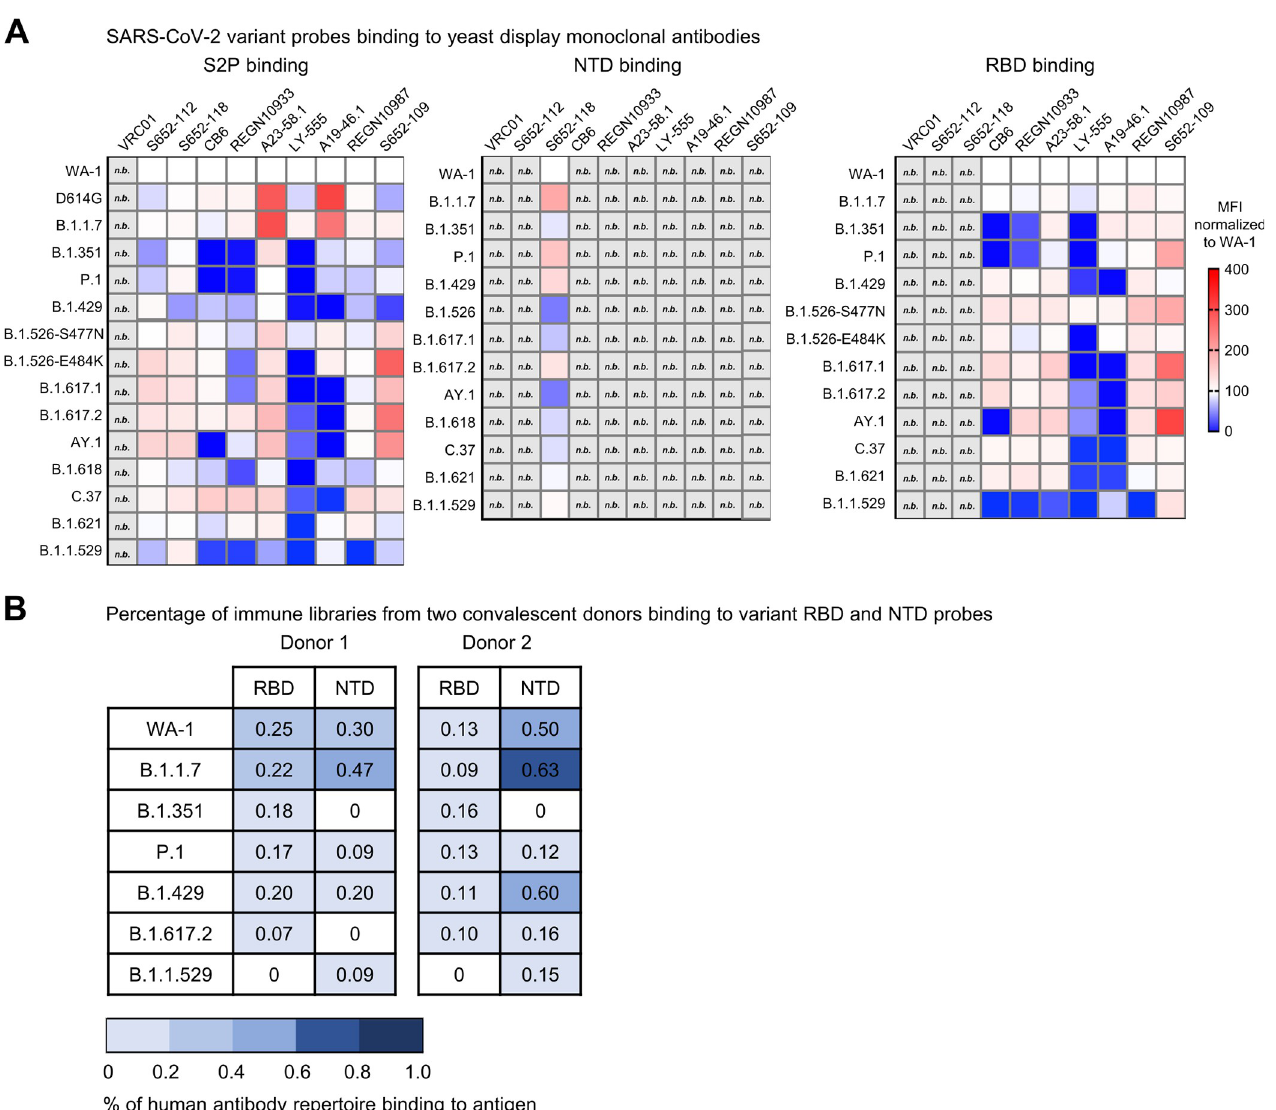
Fig 8. Interrogation of SARS-CoV-2 probes using yeast displaying anti-SARS-CoV-2 spike Fabs and immune libraries. (A) Binding of yeast expressing SARS-CoV cross-reactive Fabs (S652-112, S652-118, and S652-109), SARS-CoV-2 Fabs (CB6, REGN10933, A23-58.1, LY-555, A19-46.1, and REGN10987) or HIV targeting VRC01 Fab to SARS-CoV-2 WA-1, variant D614G, B.1.1.7, B.1.351, P.1, B.1.429, B.1.526-S477N, B.1.526-E484K, B.1.617.1, B.1.617.2, AY.1, B.1.618, C.37, B.1.621, and B.1.1.529 spike ectodomain S2P-APC (left), NTD-BV711 (middle), and RBD-BV421 (right). Binding to the indicated yeast displayed antibody was measured with flow cytometry. Data are shown as Mean Fluorescence Intensity (MFI) for the same antibody against the parental strain WA-1 probe. The normalized percent change is indicated by a color gradient from red (increased binding, Max 400%) to white (no change, 100%) to blue (complete loss of binding, 0%). Within each class of probe (i.e., S2P, NTD and RBD), yeast expressing Fab but do not bind any probes are shown in light grey and marked as “n.b.”. (B) Percentage of human antibody repertoire binding to NTD and RBD of SARS-CoV-2 variants. Natively paired antibody heavy and light chains were captured from COVID-19 convalescent patient immune repertoires and displayed as Fabs on the surface of yeast. Probe binding to the yeast-displayed Fabs was analyzed against pre-conjugated SARS-CoV-2 biotinylated variant probes and measured with flow cytometry. Numbers represent the percentage of binding to the biotinylated probes after subtracting the background